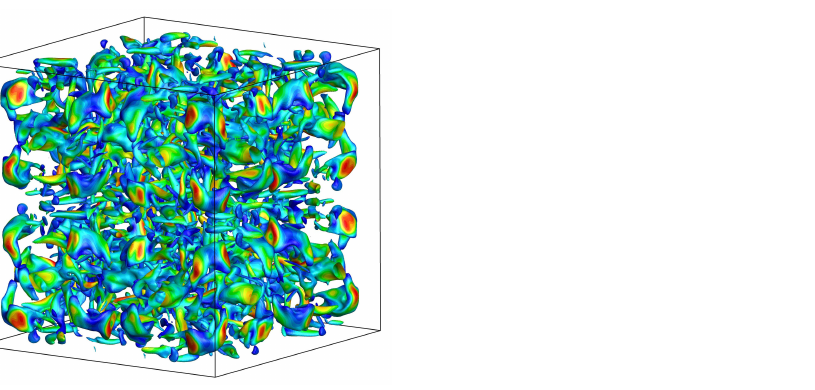
Figure 8. Snapshot of the potential field decorated by the kinetic energy for t = 20, n c = 256 3 et n e ≈ 50 × 10 6